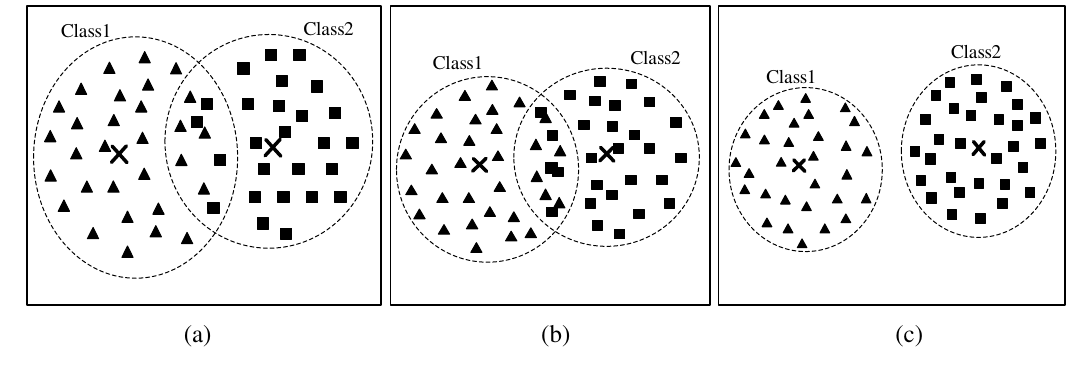
Visualization of classification results using different loss